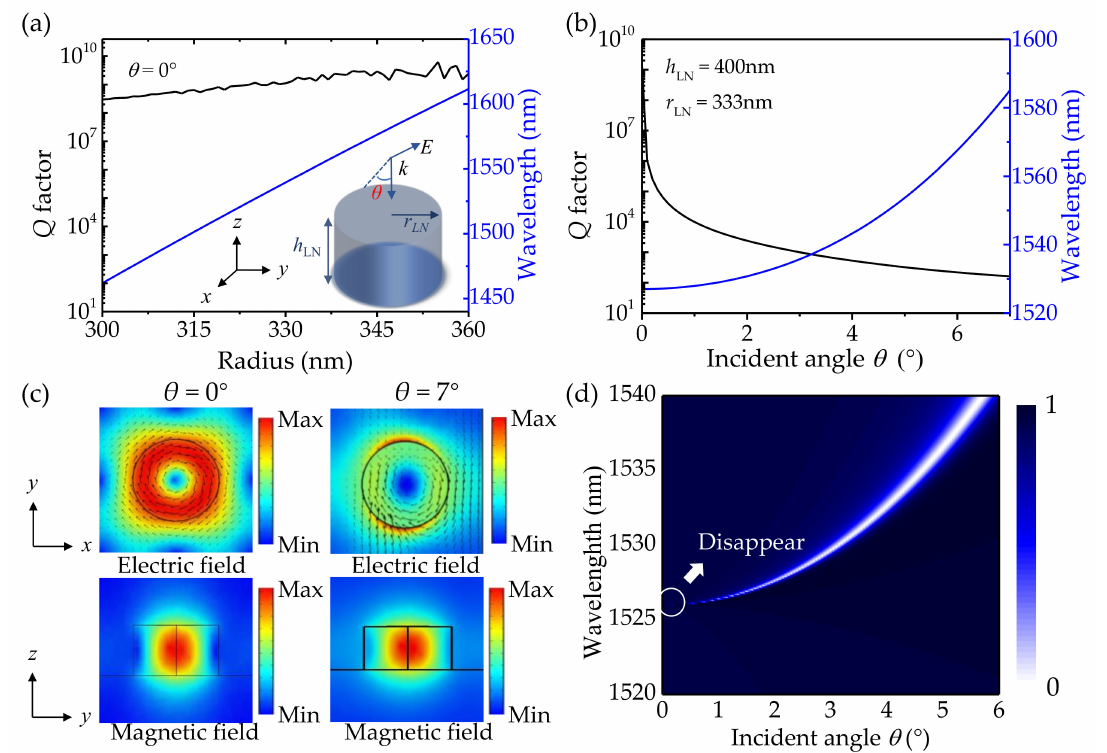
Figure 1. ( a ) The dependence of the Q factors and resonant wavelengths on the radii at θ = 0 ◦ . Inset: the schematic diagram of a single LiNbO 3 cylinder. ( b ) The dependence of the Q factors and resonant wavelengths on the incident angle. ( c ) Electric and magnetic field distributions in the LiNbO 3 cylinder at θ = 0 ◦ and 7 ◦ , respectively. ( d ) Angular-resolved transmission spectrum calculated for the periodic array with LiNbO 3